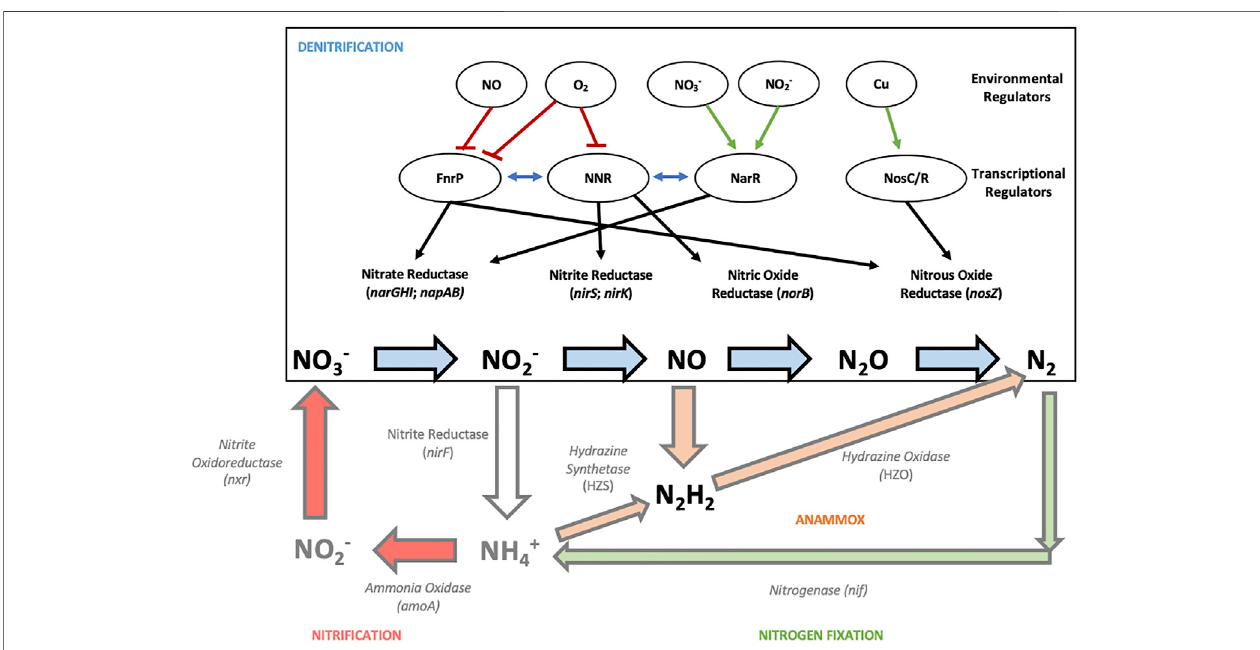
FIGURE 2 | An overview of the known transcriptional and environmental regulators of the denitri fi cation pathway in the model denitrifying bacterium Paracoccus denitri fi cans. The black and red arrows between the upper layer of the environmental regulatory signals and the layer of the regulatory proteins indicate signaling events (red indicates an inhibitory effect while green indicates activation), whilethe arrows between the regulatory proteins and the denitri fi cation enzymes indicate regulation of gene expression. The blue arrows between the transcriptional regulators indicate the cross-talk between the regulators which compete with each other to bind upstream of their